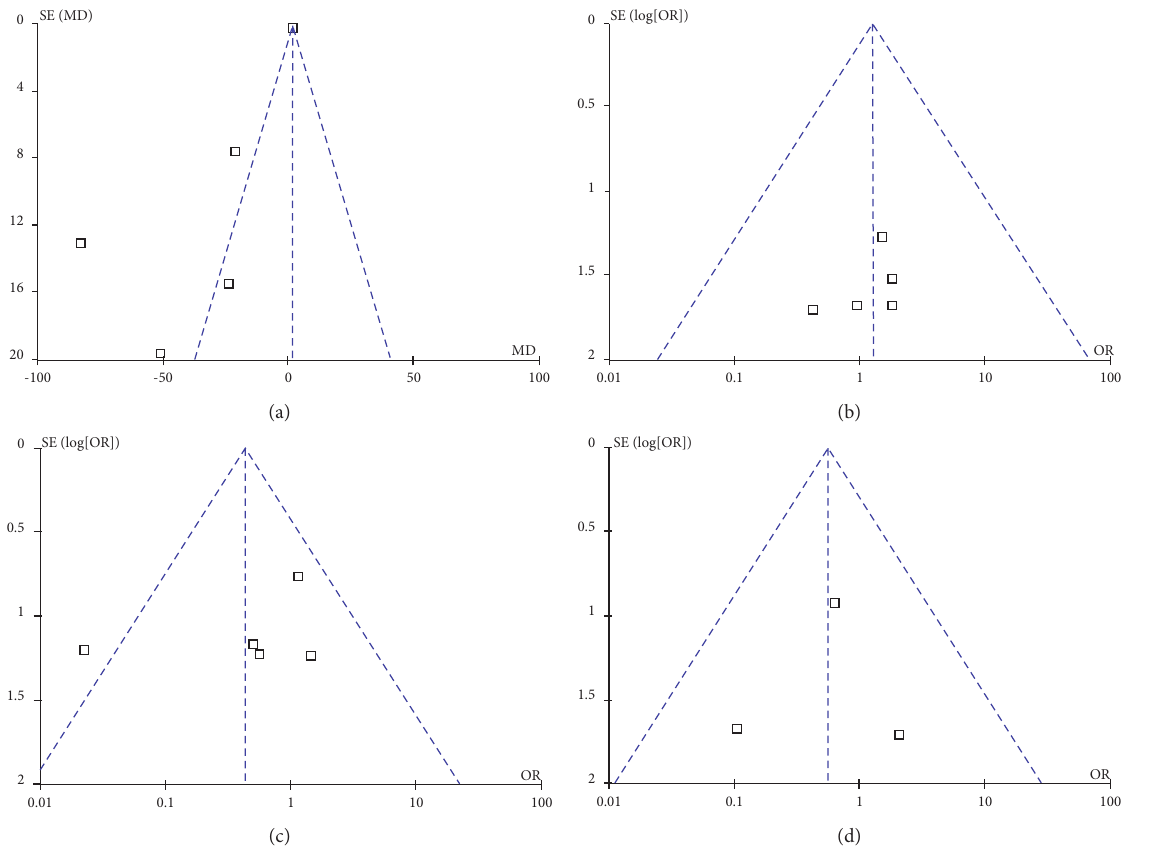
Figure 2: Funnel plot for results from included studies comparing the safety and efficacy of the surgical intervention for pancreatic pseudocyst between the laparoscopic approach and the open approach. (a) Funnel plot of operating time. (b) Funnel plot of successful rate. (c). Funnel plot of overall complications. (d) Funnel plot of mortality.